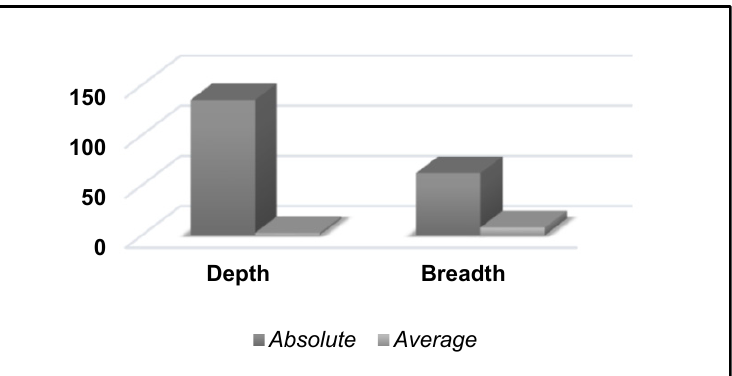
Figure 24. Mean results of schema metrics for the evolved ontology-based models using the OntoMetrics tool.